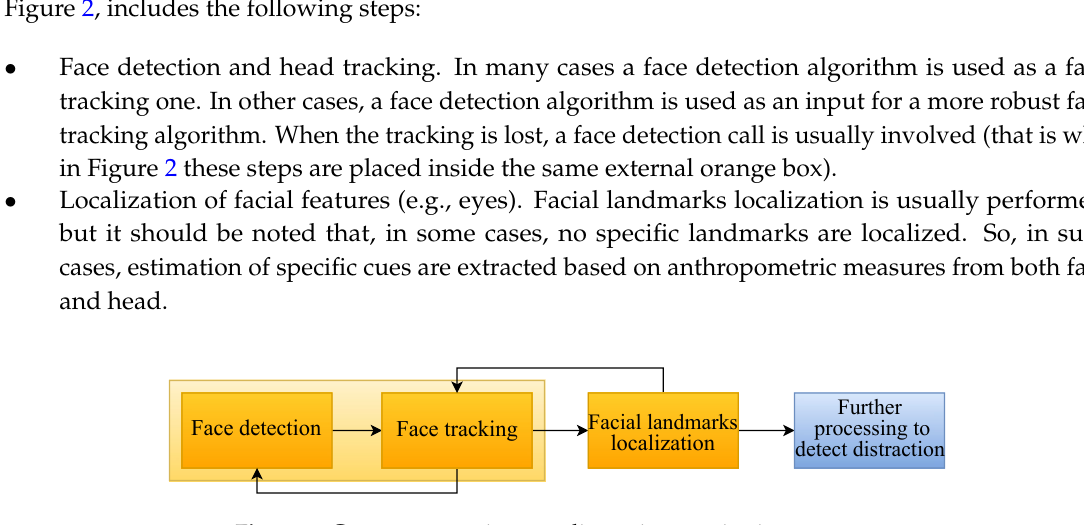
Figure 2. Common steps in most distraction monitoring